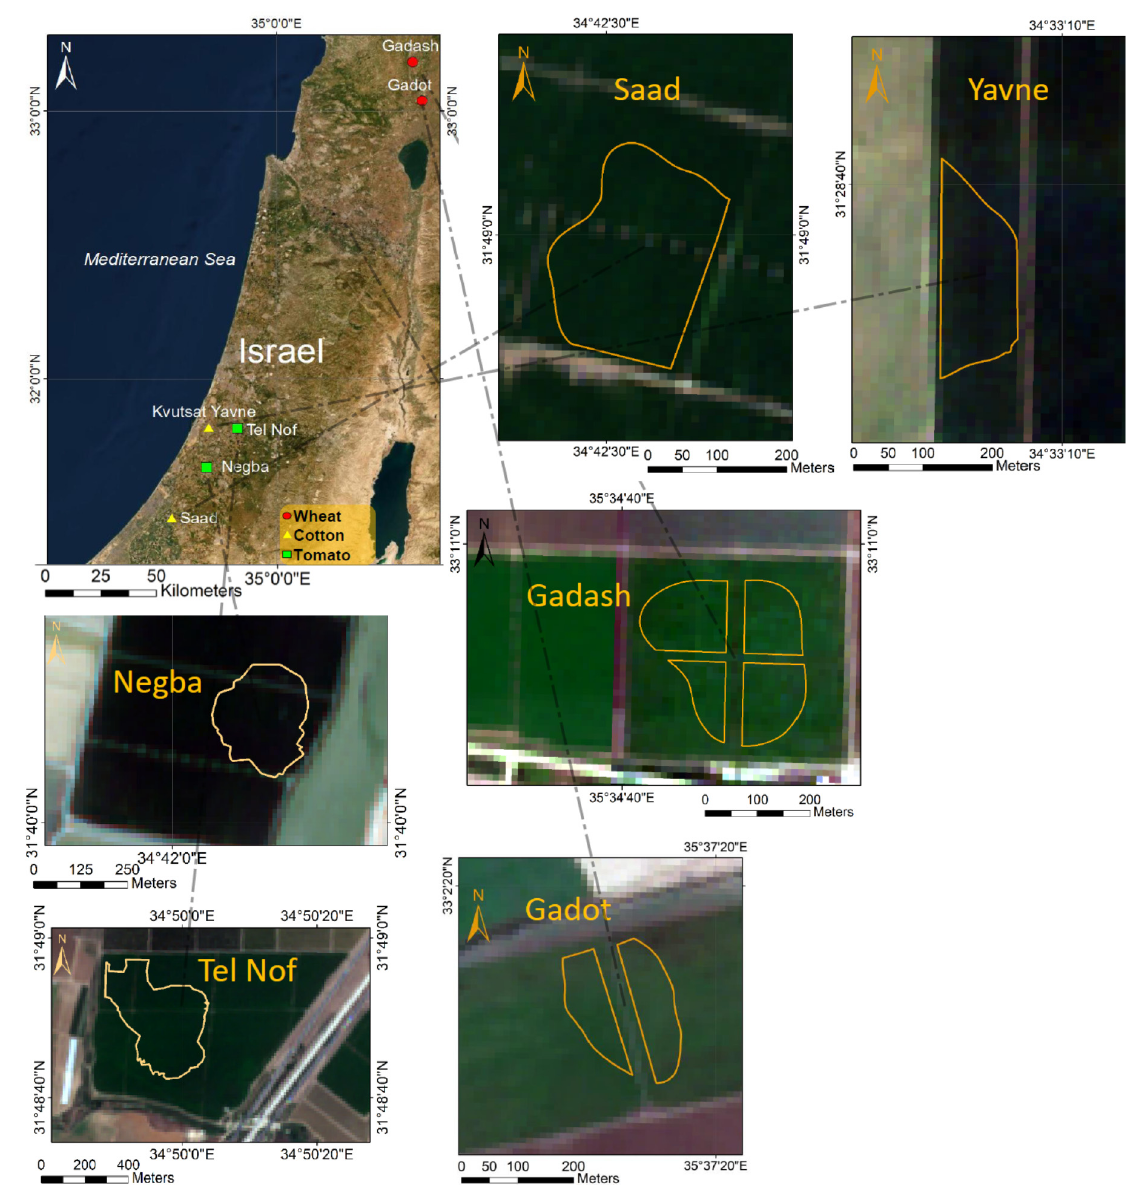
Figure 1. Locations of analysis polygons in the experiments conducted in Israel in 2016–2019.